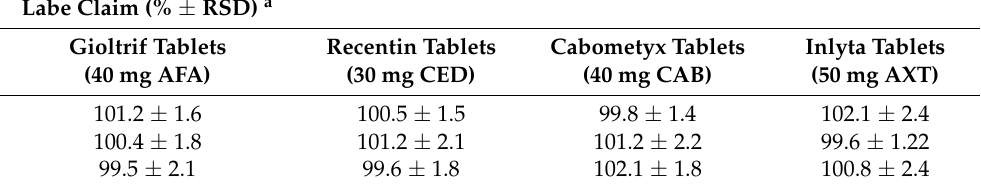
Table 9. Determination of TKIs in their pharmaceutical formulations by the proposed MW-SPA based on their CT reaction with